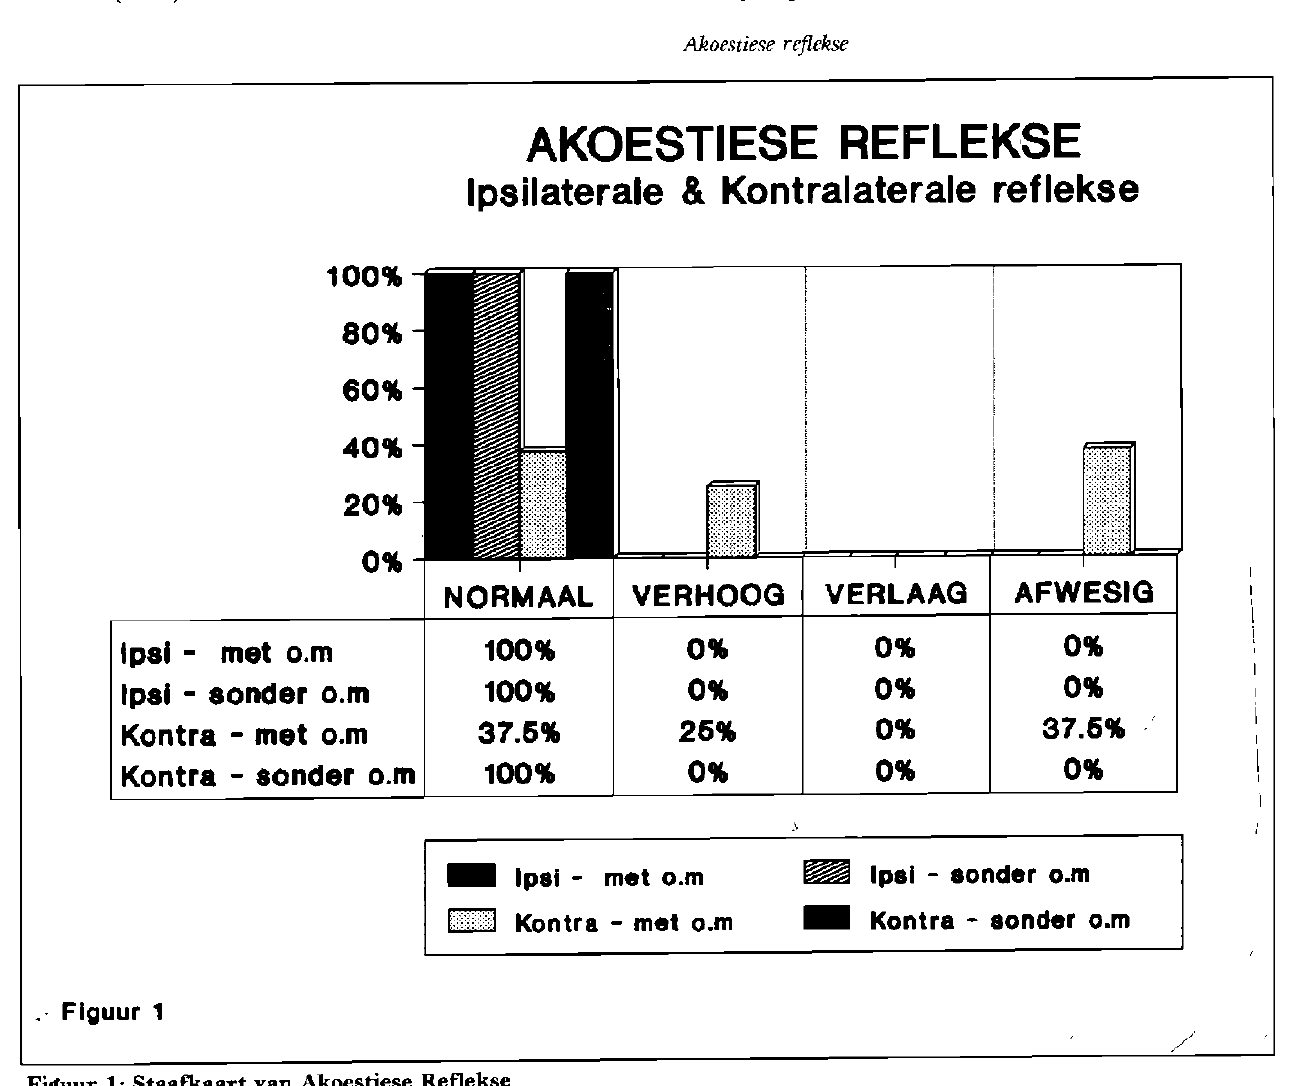
Figuur 1: Staafkaart van Akoestiese Reflekse In figuur 1 word die ipsilaterale en kontralaterale refleks- resultate uiteengesit. Dit blyk duidelik uit die voorstelling dat Groep A en Β normale ipsilateral^ reflekse vertoon